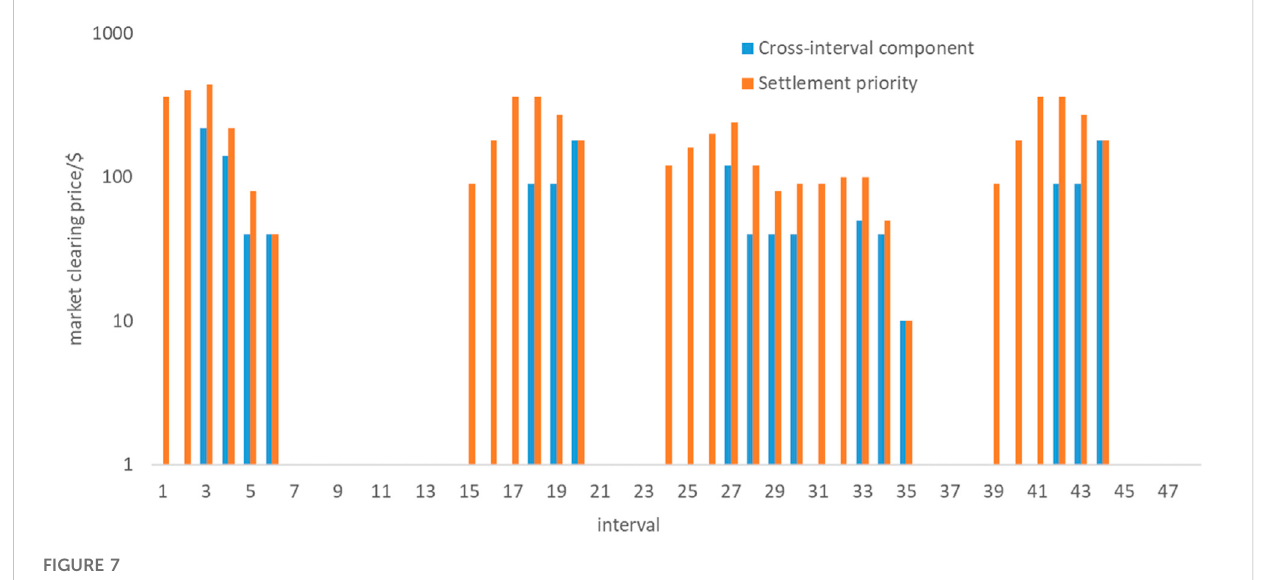
FIGURE 7 Settlement priority.